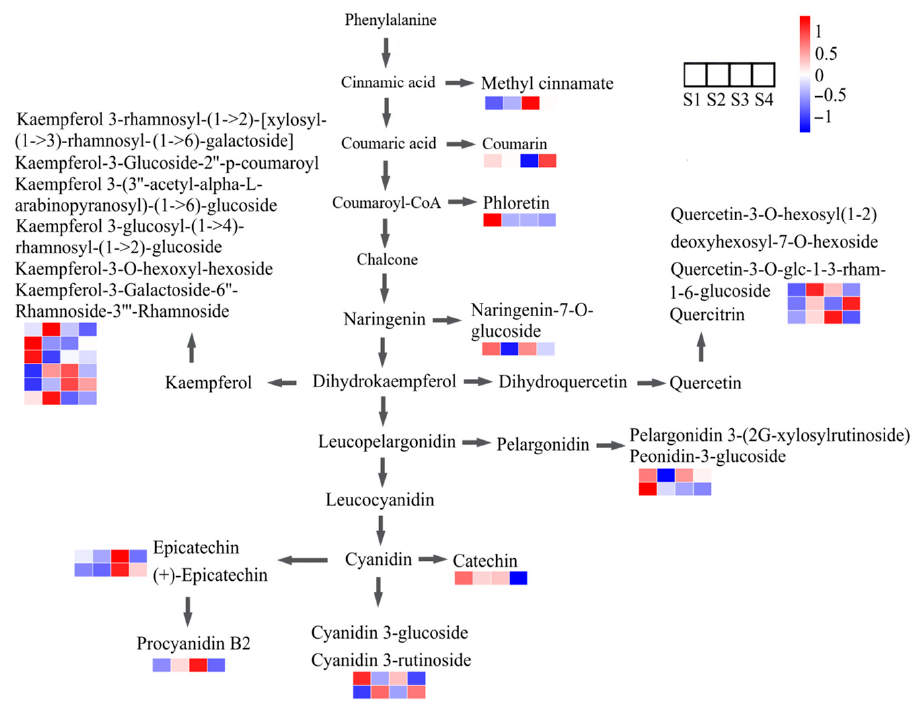
Figure 7. Metabolic pathways of flavonoids biosynthesis in C. vietnamensis seeds. Blue-white-red represented metabolites from down-regulated to upregulated.